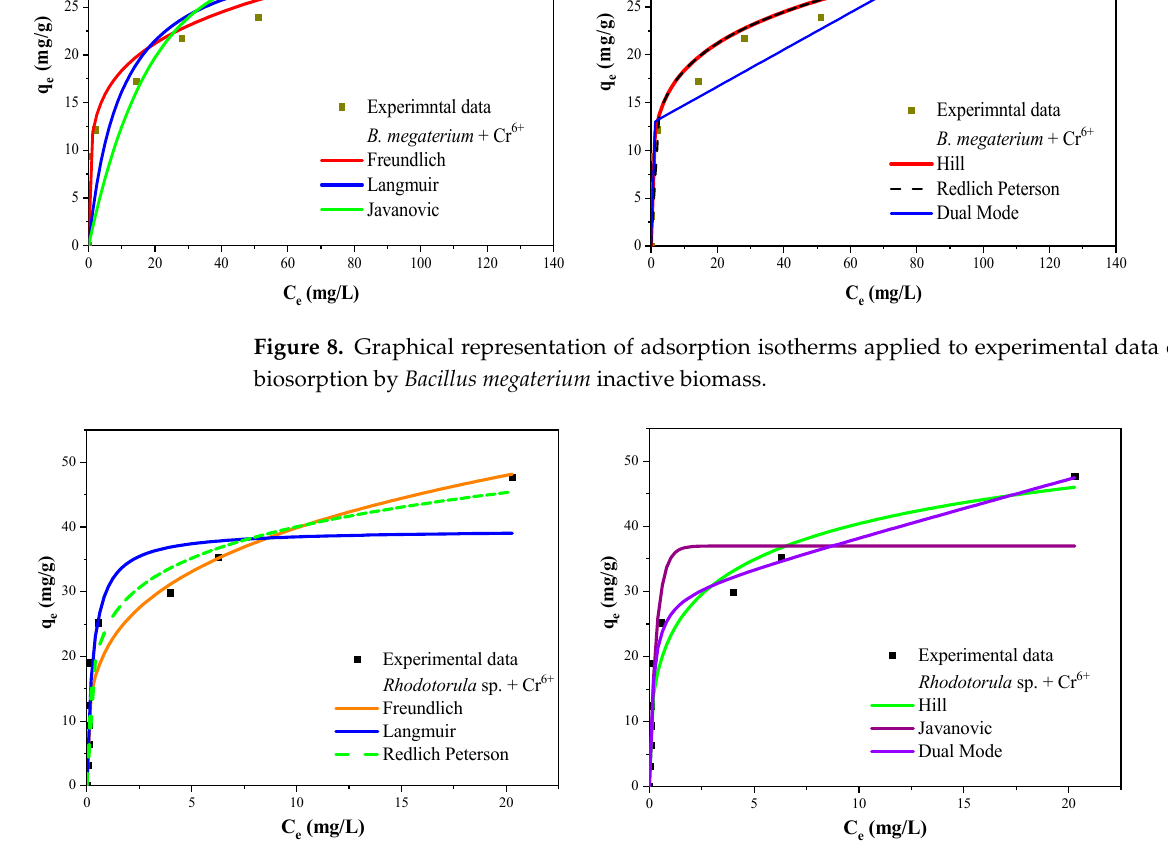
Figure 9. Graphical representation of adsorption isotherms applied to experimental data of Cr 6+ biosorption by Rhodotorula sp. inactive biomass. Table 4. Values of isotherm parameters applied to experimental data from the chromium ion bio ‐ sorption.